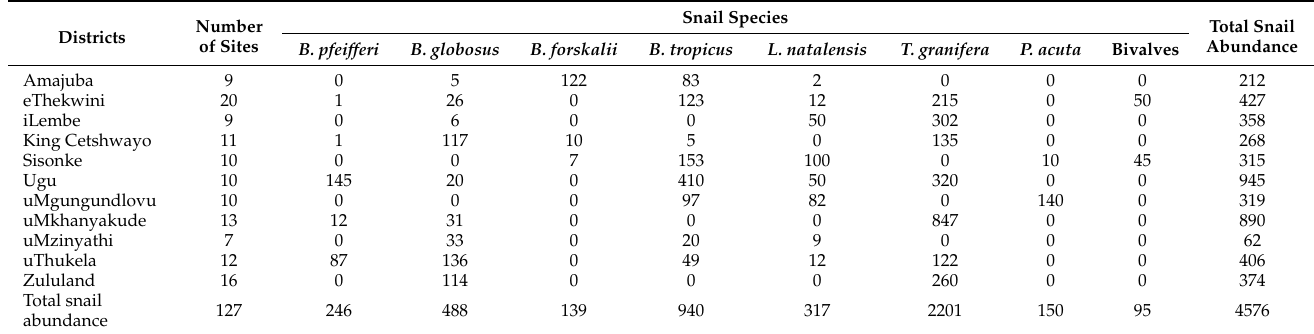
Table 1. Summary of the distribution and abundance of freshwater snails collected from 127 sites in 11 districts in KZN between December 2020 to February